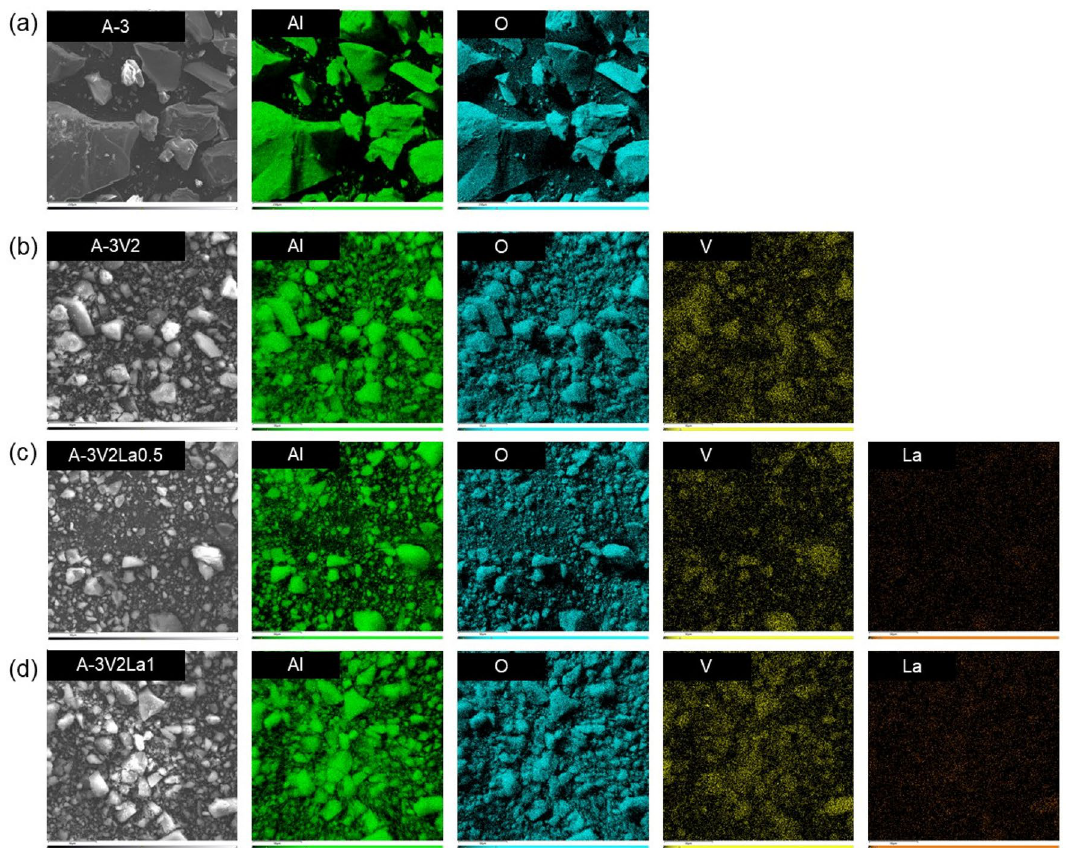
Figure 3. EDX surface mapping of ( a ) A-3, ( b ) A-3V2, ( c ) A-3V2La0.5 and ( d ) A-3V2La1 samples, including SEM image and images showing distribution of Al, O, V and